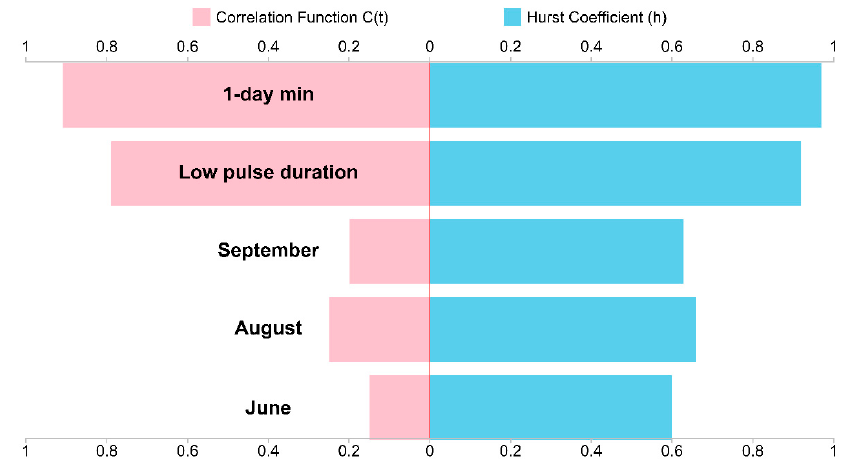
Figure 8. Variation intensity of ERHIs.